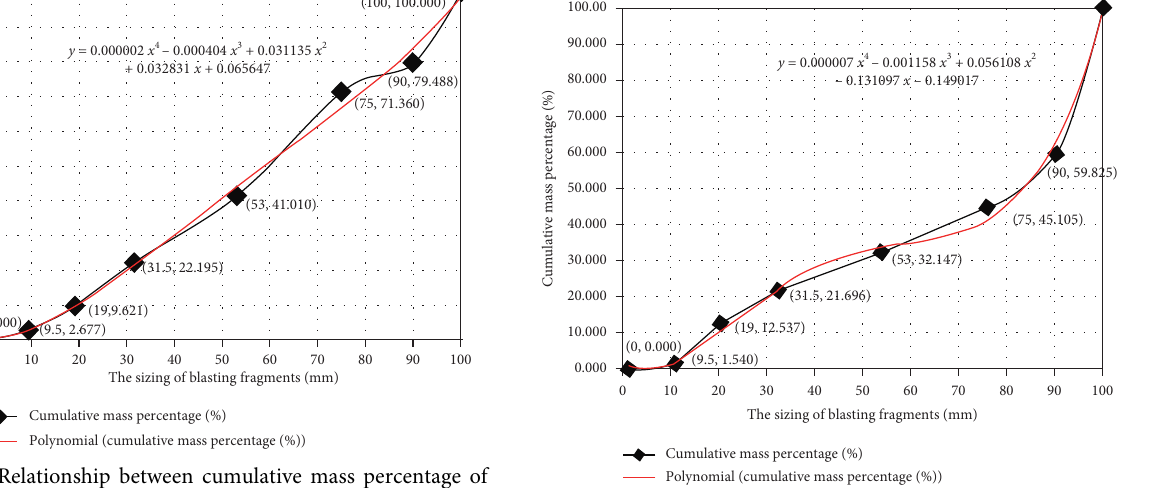
Figure 17: Relationship between cumulative mass percentage of blasting fragments and fragment size particle diameter of 77 ° wedge cutting.